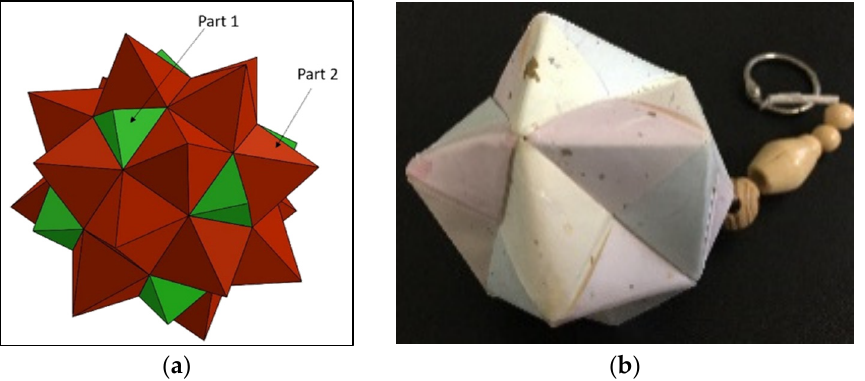
Figure 2. ( a ) Origami bubble aggregate (OBA); ( b ) Kusudama origami that inspired the